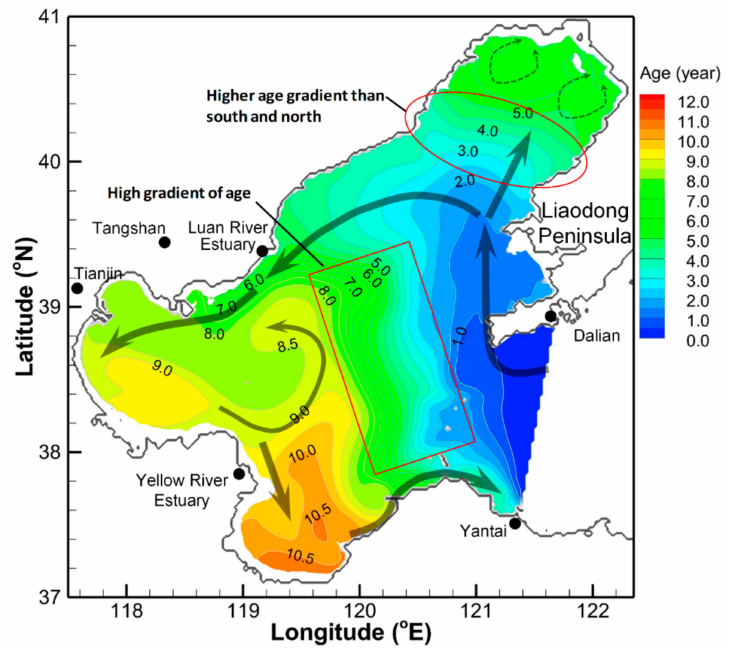
Figure 5. Monthly averaged age with water movement forced only by tidal action. The gray arrows represent the long-term water transport route deduced from the age